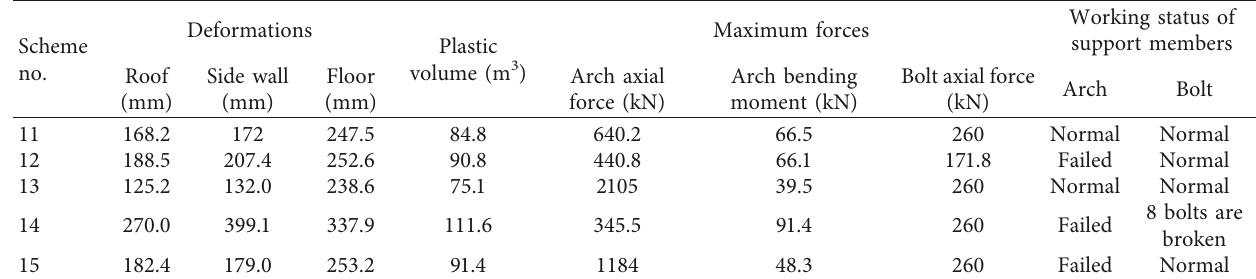
Table 7: Main results of Schemes 11–15 at the 50 th day.